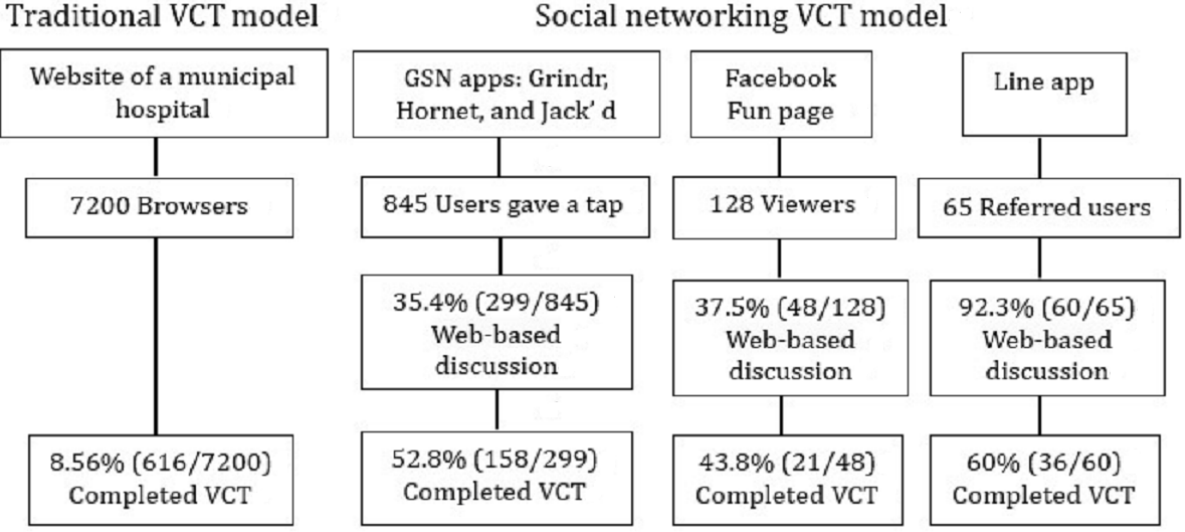
The most popular designated testing period of the